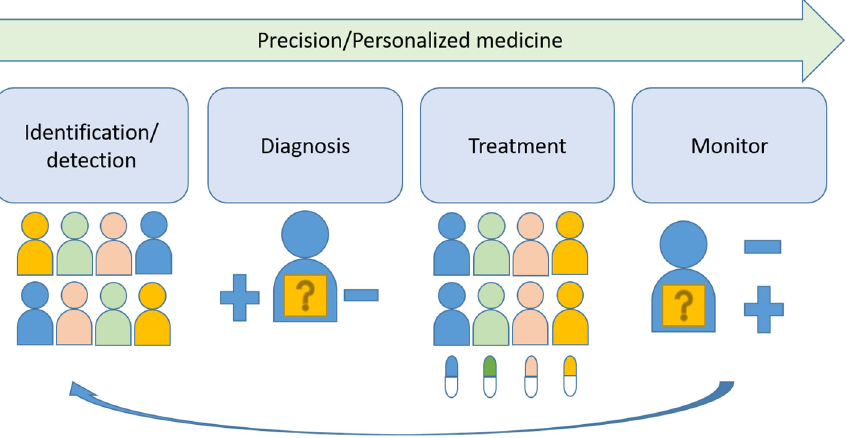
Figure 1. Schematic illustration of key steps of precision medicine.